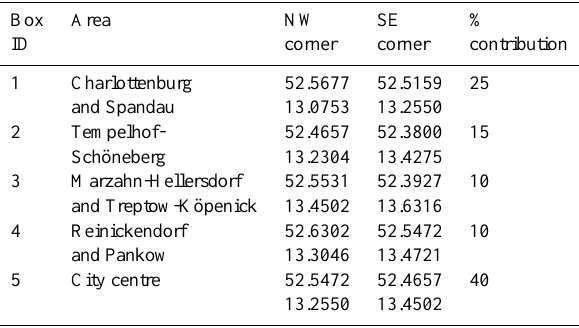
Table 3. The five emission regions used in the dispersion model. The last row provides the percentage contribution to the total emis- sion strength of the Berlin source as assumed in the model. Box Area NW SE % ID